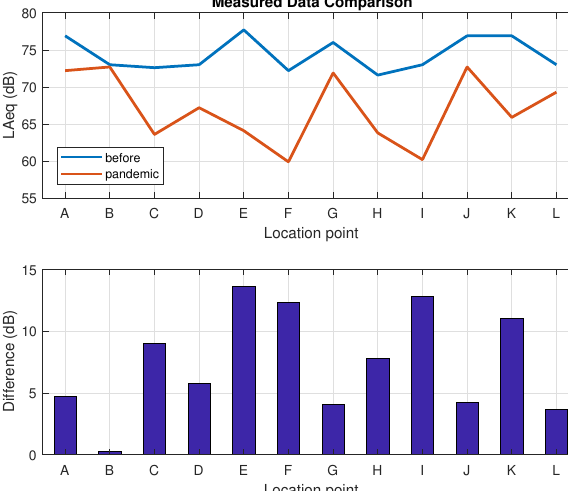
Figure 7: Measured levels comparison before and during pandemic period